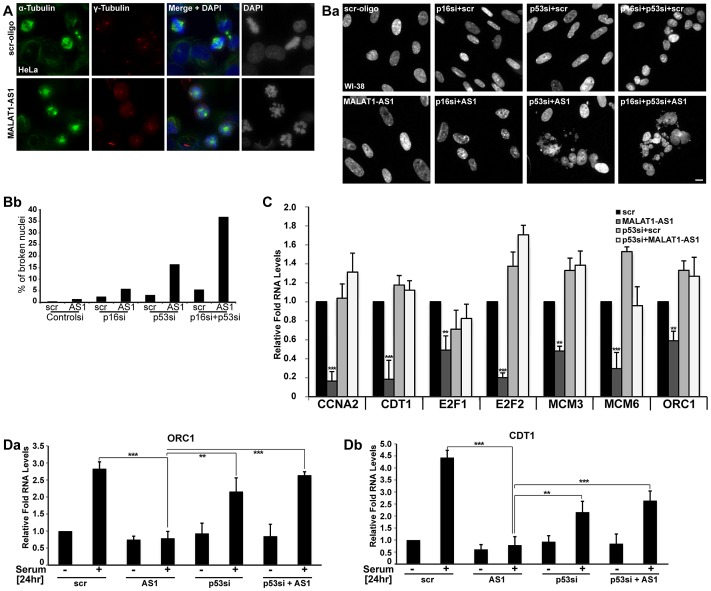
p53 is a downstream mediator of MALAT1.(A) Immuno-localization of α- and γ-tubulin in control (scr-oligo) and MALAT1-depleted (MALAT1-AS1) HeLa cells. Note the presence of monopolar and multipolar asters and highly condensed chromosomes in MALAT1-depleted cells, indicating chromosome segregation defects. (Ba) DNA staining (using Hoechst 33258 dye) in WI-38 cells reveals that co-depletion of MALAT1 and p53 or p53/p16Ink4A results in nuclear breakdown defects. (Bb) Percentage of broken nuclei in control and MALAT1-depleted WI-38 cells in presence or absence of p53 and/or p16Ink4A. (C) The relative expression of indicated genes is determined by qRT-PCR analyses from RNA isolated from WI-38 cells that are treated with control or p53 siRNAs and/or control or MALAT1 antisense oligonucleotides. (Da–b) Serum-starved WI-38 cells that are depleted of p53 or MALAT1 or p53 + MALAT1 followed by serum stimulation, and relative mRNA levels of indicated genes are determined by qRT-PCR analyses. The DNA is counterstained with DAPI (A) or Hoechst 33258 (B). Scale bar represents 5 µm. Mean ± SEM,**p<0.01 and ***p<0.001.